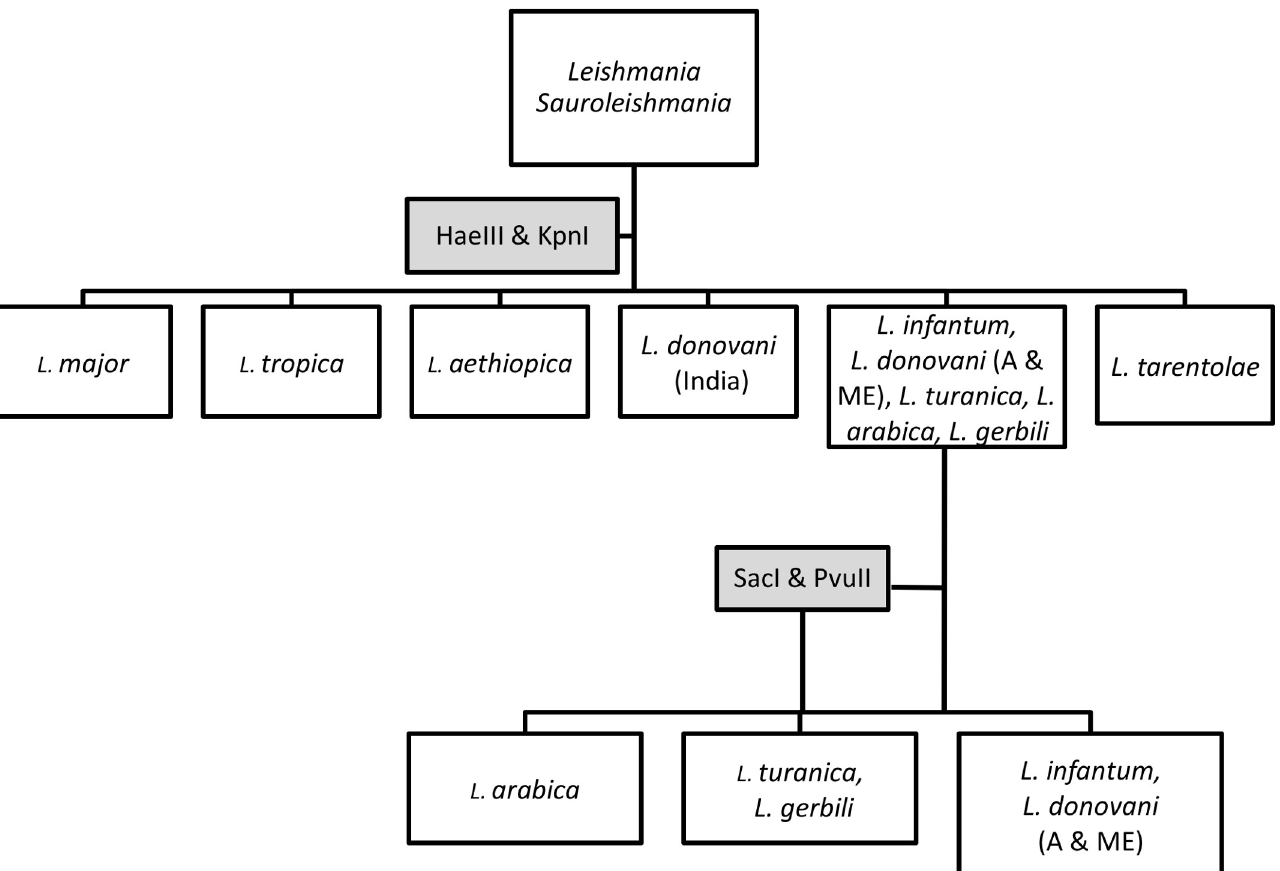
Fig 5. PCR-RFLP algorithm for identification of Old World Leishmania species using DPPIII gene as target and DPPIII F/R primers pair. A: African, ME: Middle Eastern.